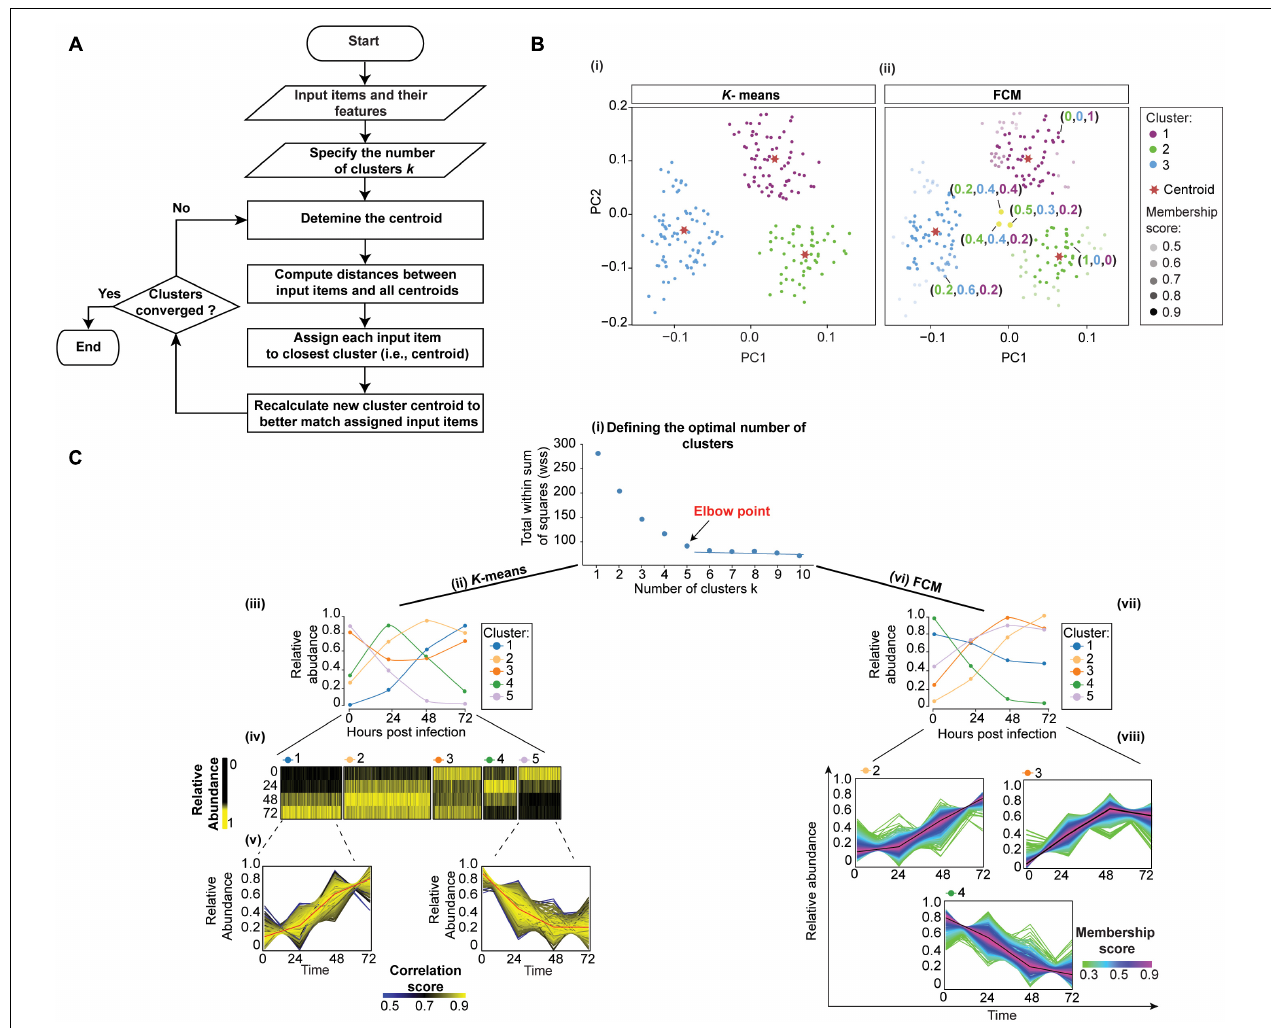
FIGURE 4 | Clustering temporal HPI data using K -means (crisp clustering) and Fuzzy C-means (FCM, soft clustering) methods. (A) Flowchart of the unsupervised K -means algorithm. Initialization, iterations, and termination in FCM are the same as in the K -means algorithm. However, FCM uses a weighted centroid based on memberships of data points within each cluster because membership scores can vary from 0 to 1. (B) We illustrate the difference between K-means (i) and FCM (ii) by using mock temporal HPI data with 3-time points and principal components to display the data. (i) K -means divides data into three distinct clusters. (ii) On the other hand, FCM assigns each data point coefficients that reflect memberships in each of the clusters and range from 0 to 1. Then, each data point is assigned to the cluster in which its membership is highest. Some proteins (yellow dots) are assigned high membership coefficients to more than one cluster. (C) To demonstrate the application of K -means and FCM, we randomly selected 3,000 proteins from experiment 1 data by Weekes et al. (2014) and used the Elbow method to define 5 as the optimal number of clusters for both K -means and FCM; the plot for K -means is shown (i). We then used K- means (ii–v) and FCM (vi–viii) to cluster the data. The results of the K -means clustering are displayed (iii) as centroid (or average) temporal profiles of each cluster, and (iv) as heatmaps. (v) Each cluster can also be visualized by displaying the data for all proteins in the cluster, and coloring the corresponding protein profiles based on how well they correlate with the cluster’s centroid (red line); examples for clusters 1 and 5 are shown. Here, proteins with similar profiles to the cluster’s centroid have a score approaching 1 (yellow), while those with divergent patterns have a correlation score closer to 0 (blue). This plot can help filter proteins whose profiles don’t fit well into the selected cluster or identify core proteins of particular interest with profiles closely matching the centroid. Likewise, FCM results are displayed as the centroid temporal profile of each cluster (vii). (viii) Clusters can also be visualized by displaying each protein and color-coding its profile according to its membership in the respective cluster; plots for clusters 2, 3, and 4 are shown. Here, proteins with a profile close to the cluster’s centroid (black lines) have a membership score close to 1 (purple). These proteins are prominent members of a cluster (viii). In contrast, proteins with divergent patterns have a score closer to 0 (green). One may wish to apply a membership score threshold to eliminate proteins with divergent patterns from the downstream analyses of the